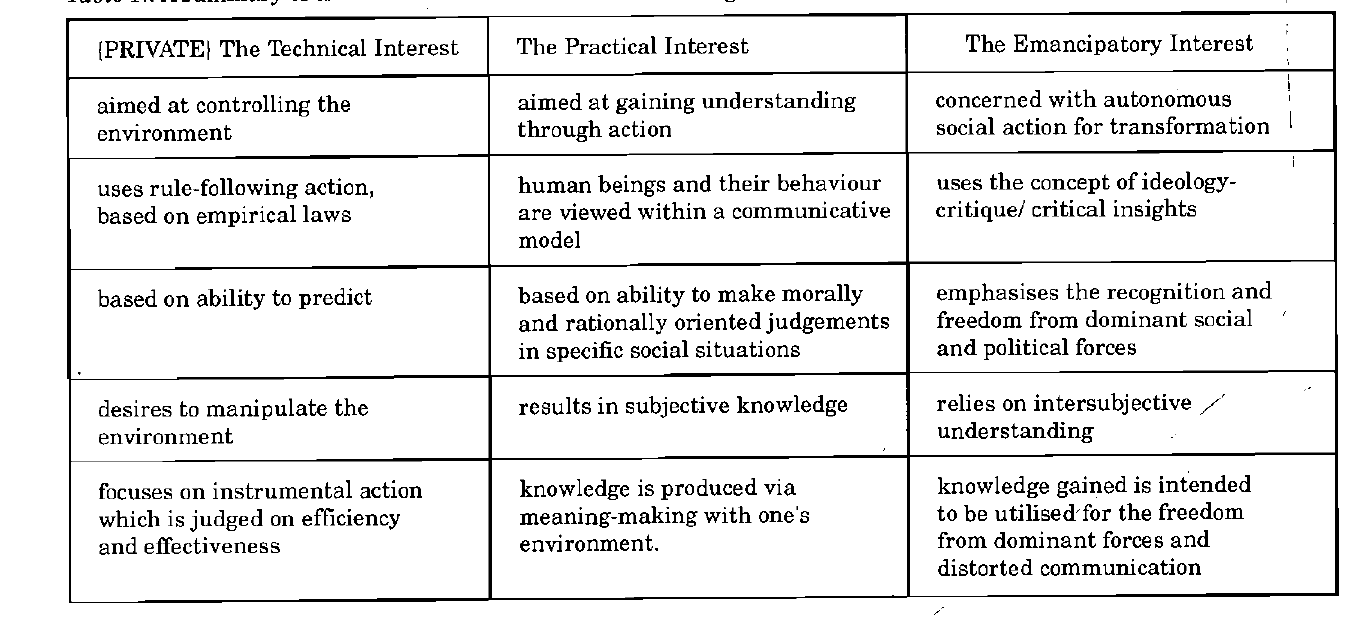
Table J.: A summary of the main features of the three knowledge-constitutive interests. (PRIVATE) The Technical Interest aimed at controlling